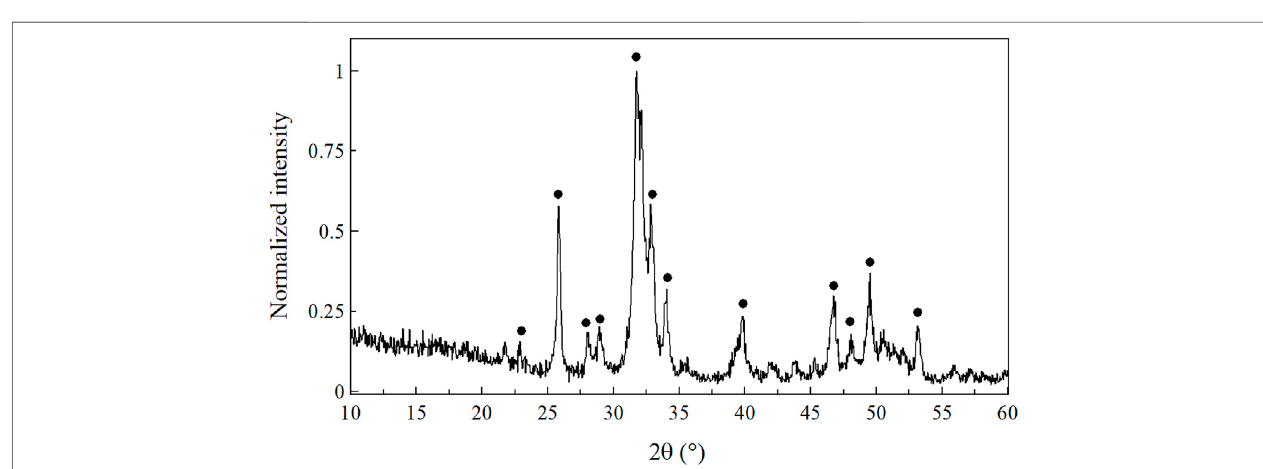
FIGURE 3 | XRD spectrum of TCP particles.